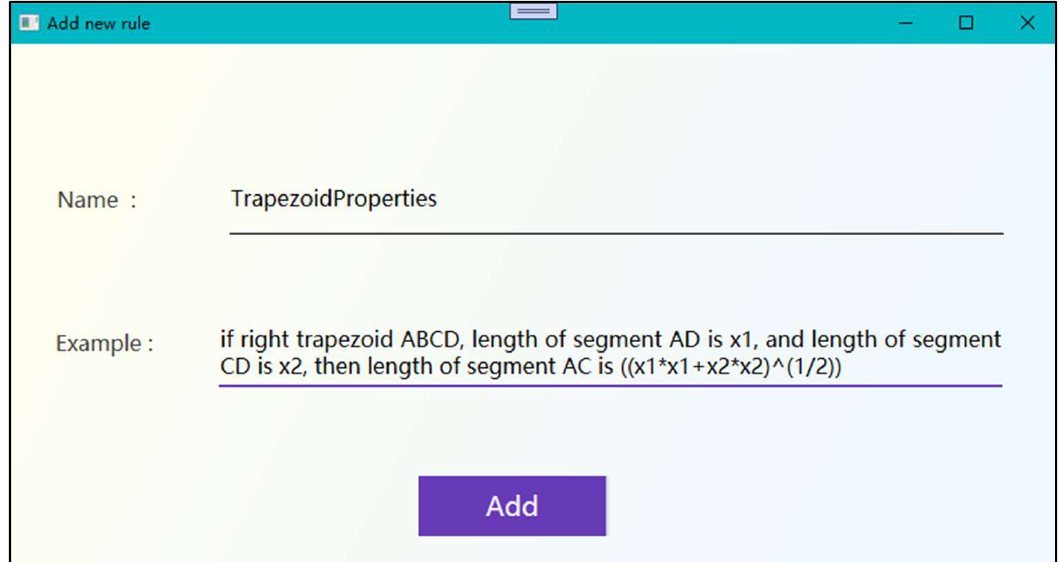
Figure 10. Rule addition.